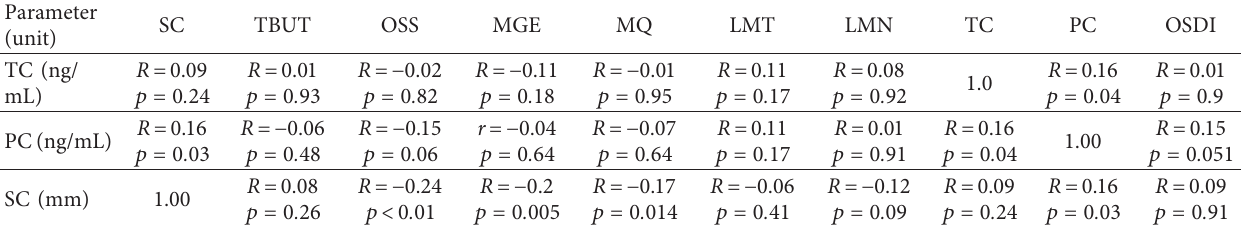
Table 2: Correlation between serum hormones concentration and clinical parameters.